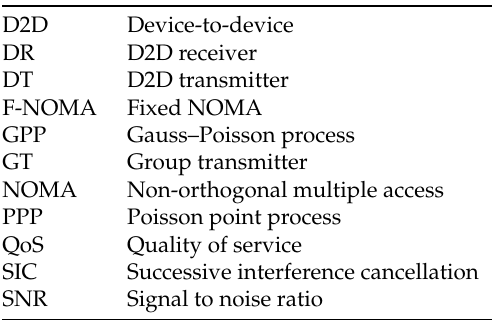
Table 1. List of commonly used